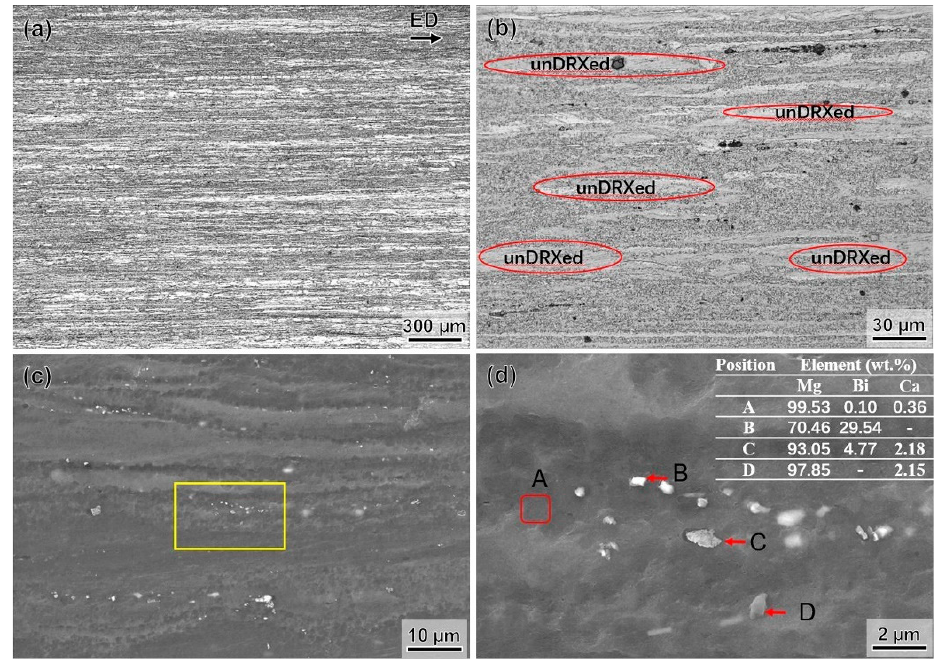
Figure 2. OM ( a , b ) and SEM ( c , d ) micrographs of the as-extruded BX11 alloy.